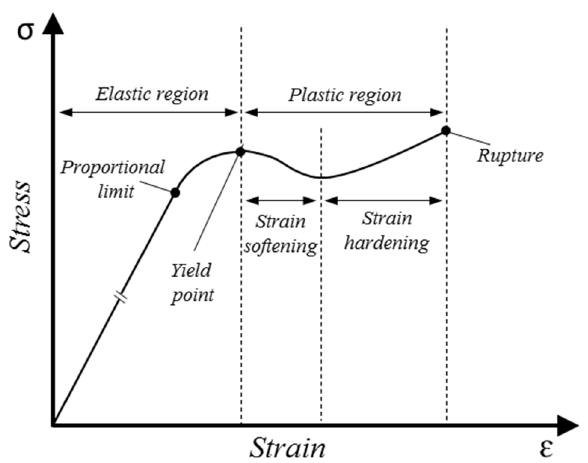
Figure 1. Typical stress-strain graph of a polymer optical fibre. Summarized from [17].